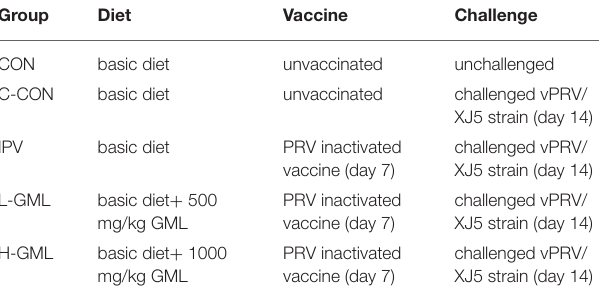
TABLE 1 | Animal experimental